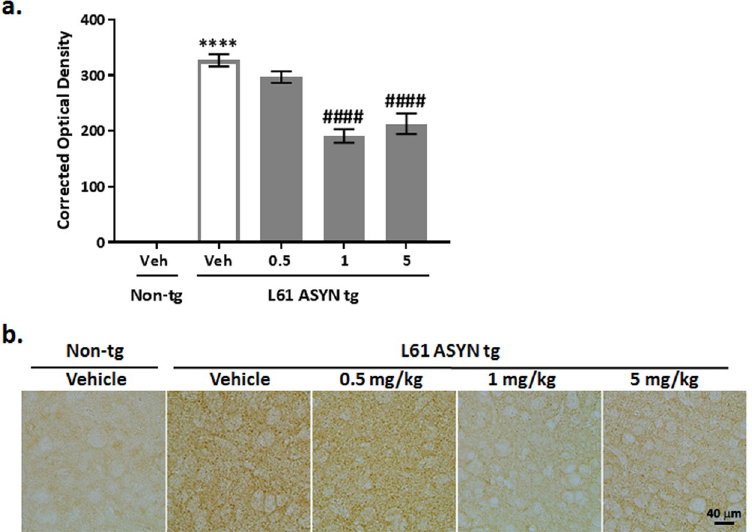
Figure 7. NPT200-11 administration decreased Proteinase K resistant ASYN immunolabeling in cortex of Line 61 ASYN transgenic mice. There was a statistically significant increase in PK + resistant ASYN immunolabeling in the cortical neuropil of Line 61 ASYN transgenic mice ( **** p < 0.0001 vs. non-transgenic/vehicle controls ). NPT200-11 administration (1 & 5 mg/kg) produced a statistically significant reduction in PK + resistant ASYN levels in the cortical neuropil of Line 61 ASYN transgenic mice ( #### p < 0.0001 vs. Line 61 ASYN transgenic/ vehicle controls ). Representative images obtained at 40x are shown in ( b ), where scale bar represents 40 microns.